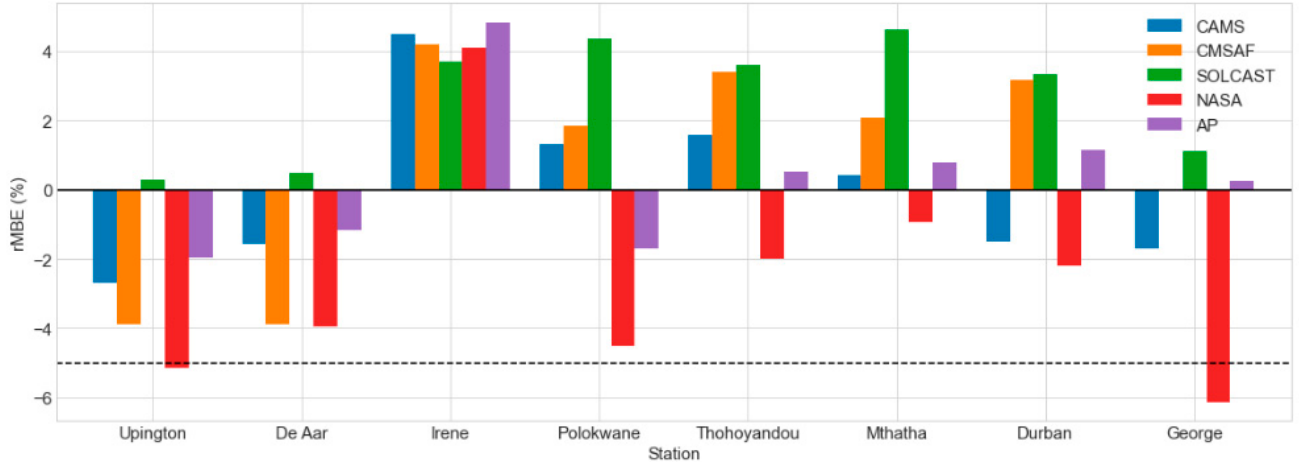
Figure 6. The daily rMBE of the estimated GHI datasets under clear skies.